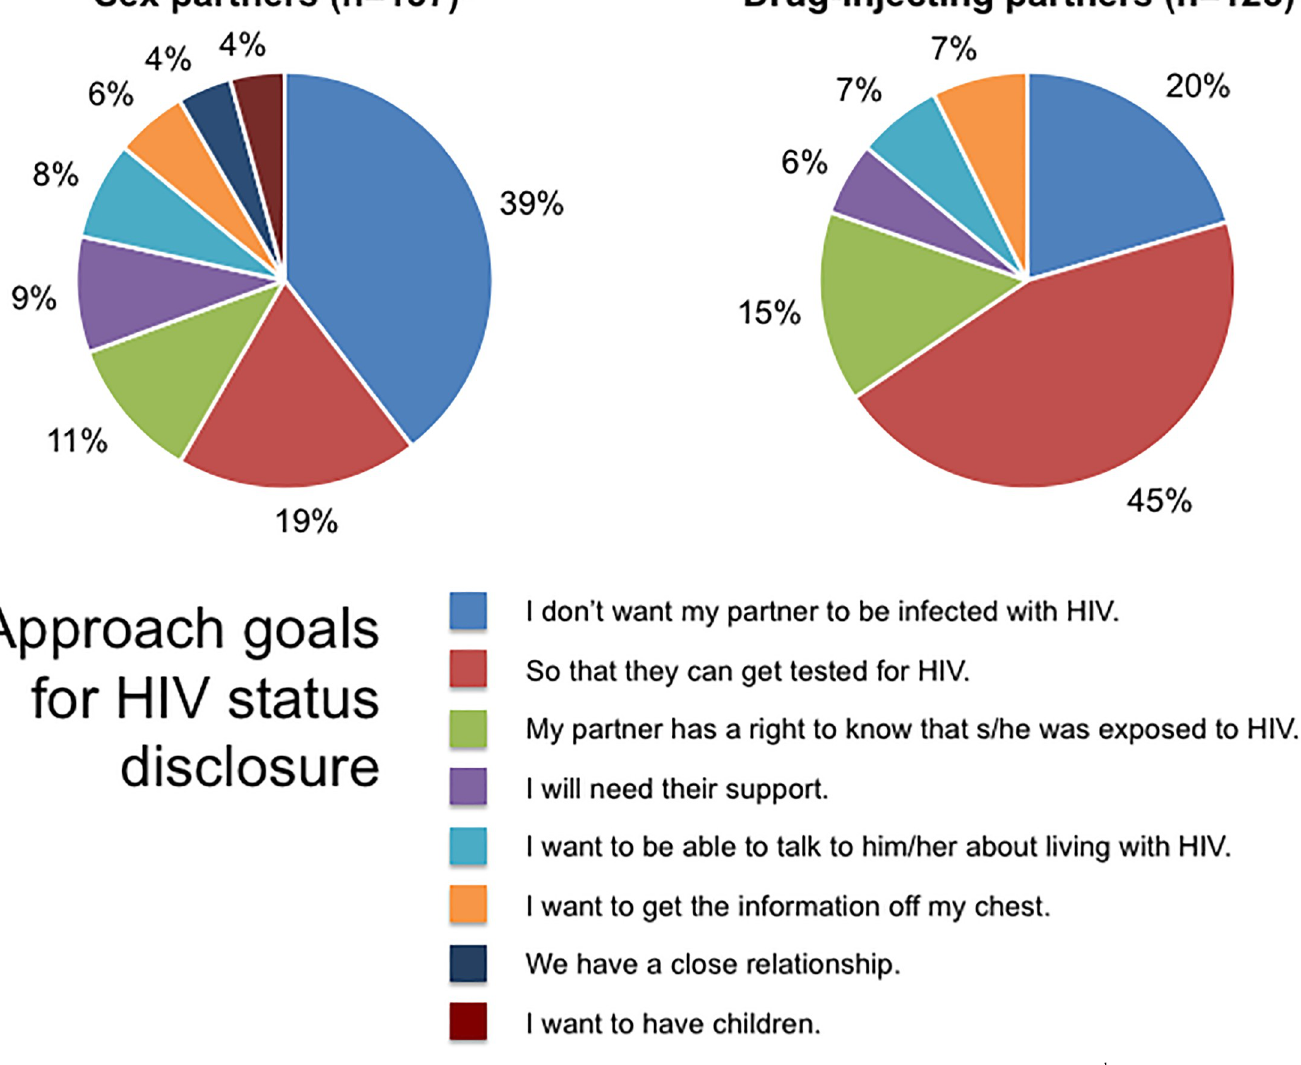
Fig 1. Approach goals for HIV status disclosure. a n = number of participants who were sexually active in the 6 months before incarceration. b n = number of participants who injected drugs before